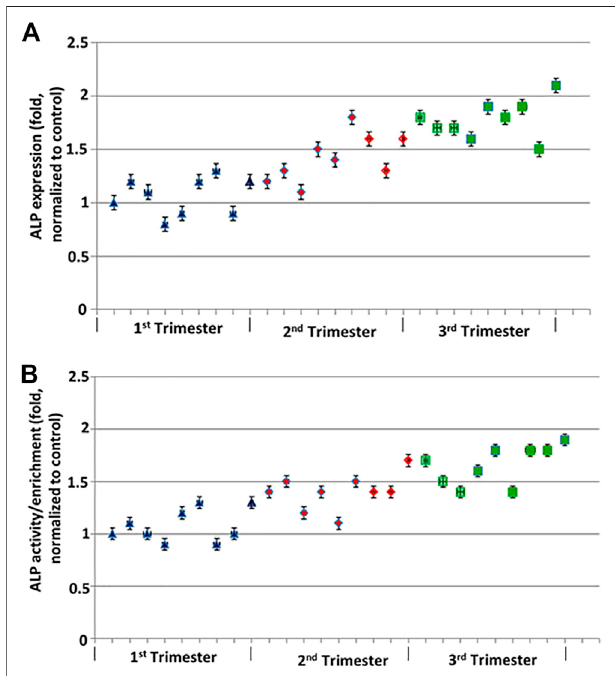
FIGURE 1 | ALP protein expression across GA normalized to Grb2. (A) Western blot analysis was performed for the expression for ALP. ALP protein levels were quanti fi ed using LICOR platform. (B) ALP activity across GA by ABCAM colorimetric assay compared to pNPP. Error bars represent standard deviation of triplicate